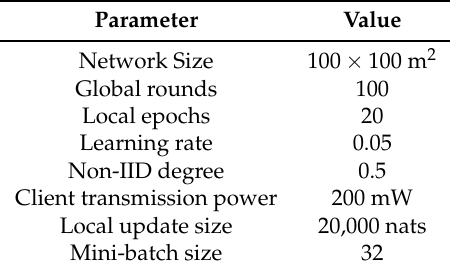
Table 3. Hyper-parameters.